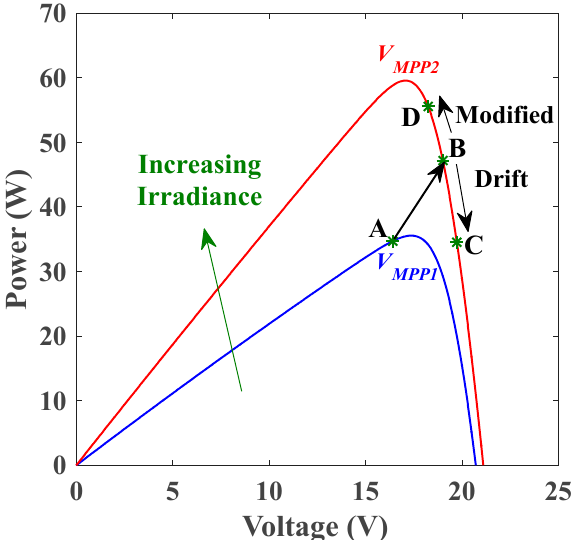
Figure 5. Drift analysis of conventional P&O versus modified P&O algorithms when considering a rapid increase in irradiance.